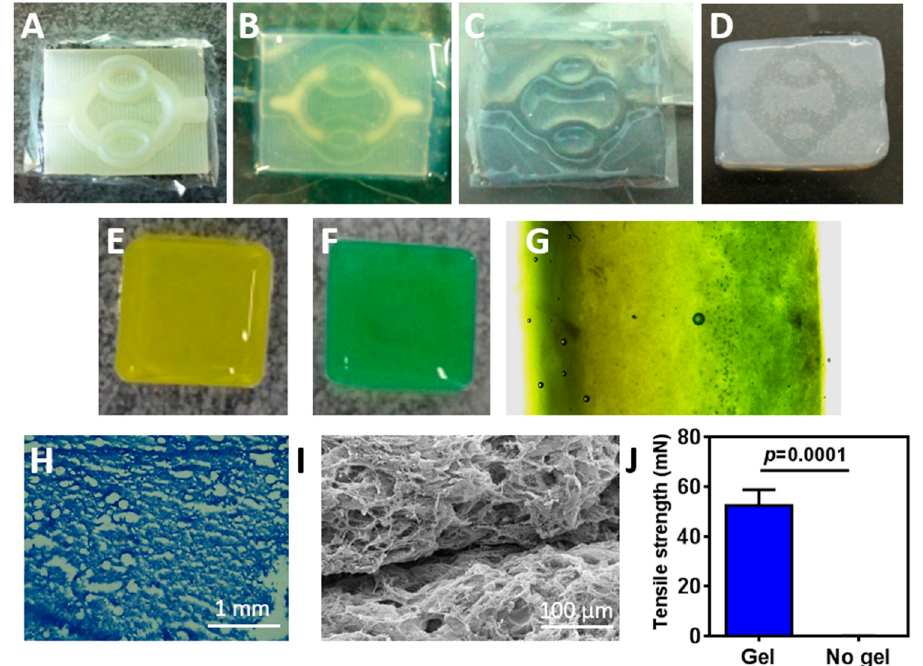
Figure 3. Fabrication and integration of the channeled hydrogel. ( A ) The template. ( B ) The casted hydrogel on the template. ( C ) The channeled hydrogel. ( D ) The entire closed channeled hydrogel after the flat top hydrogel layer was glued to the open channel layer by the liquid ECM solution. Two layers of flat hydrogel colored in different colors: ( E ) Yellow color ( F ) Green color. ( G ) The integration area between the hydrogel layers. ( H ) Masson’s trichrome (Collagen) staining in the integration zone between the hydrogel layers. ( I ) Internal morphology of the integration area between the hydrogel layers as visualized by SEM. ( J ) Tensile strength of two hydrogel layers with and without a glue hydrogel layer.